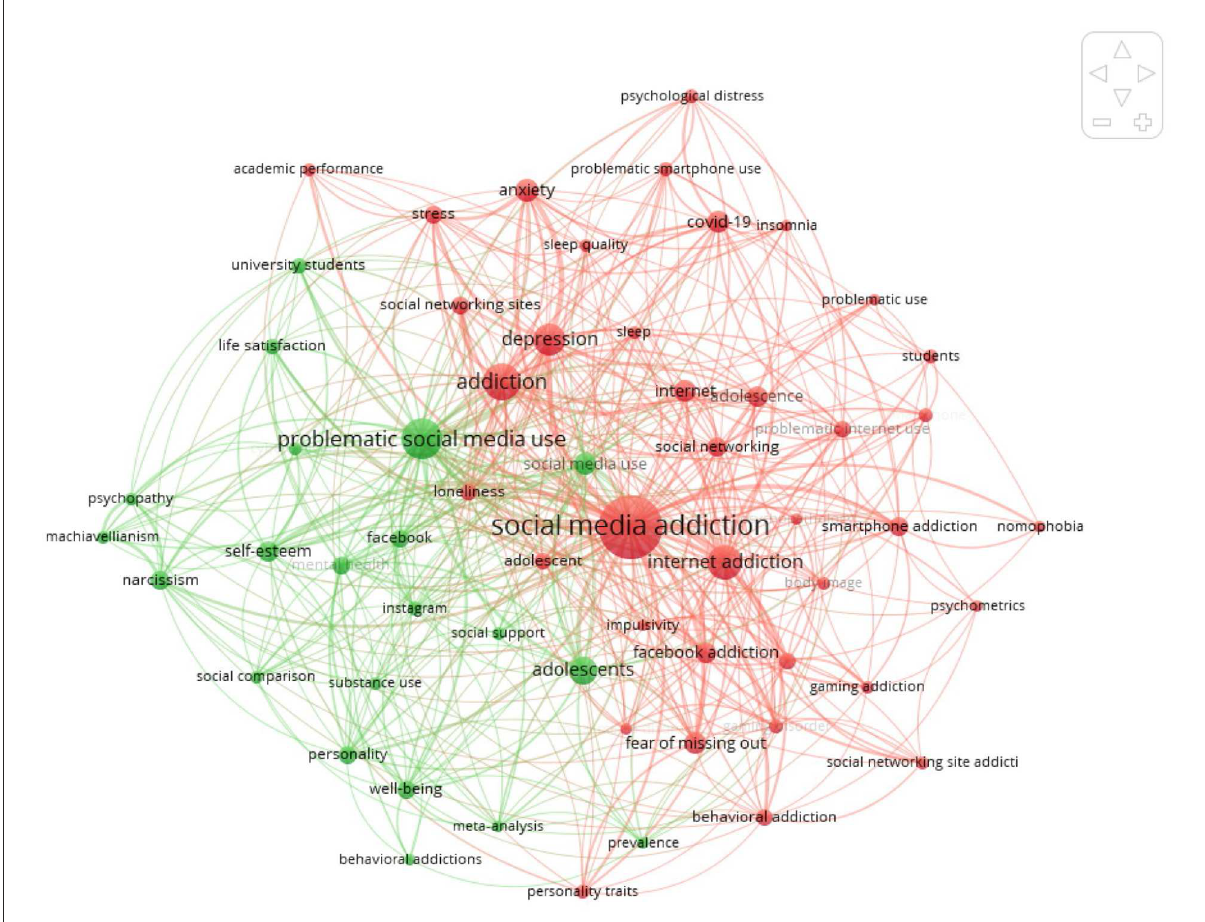
FIGURE5 Keywords co-occurrence map. Threshold: 5